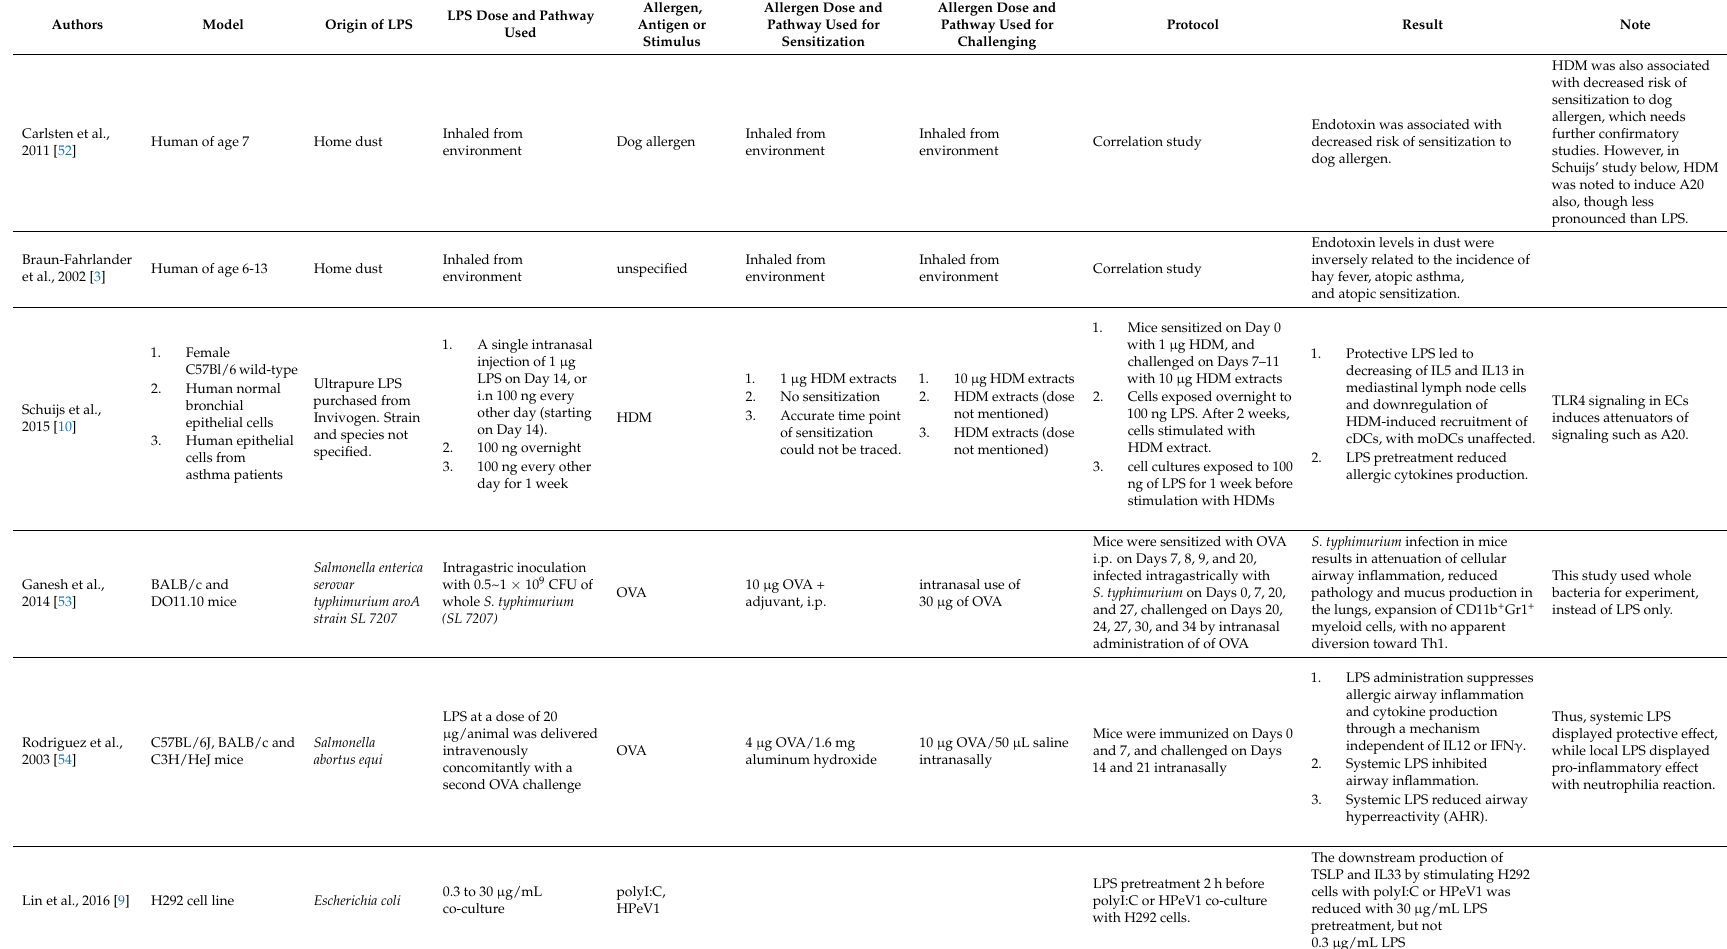
Table 2. Studies demonstrating the protective capacity of